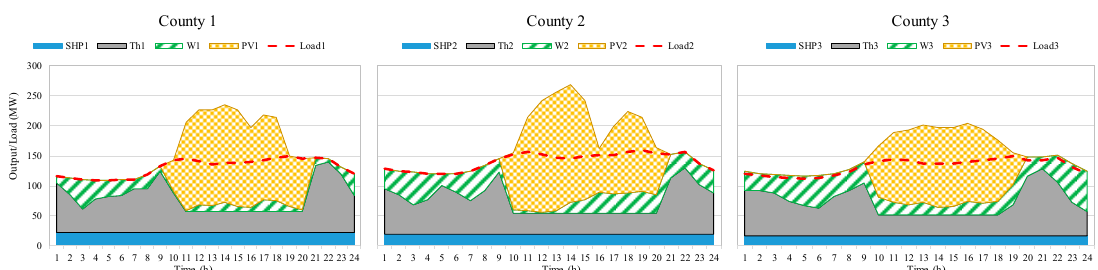
Figure 8. Output process of the county power stations in counties in the non-cooperation mode.